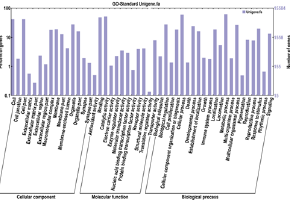
Figure 3. GO categories of the unigenes. Note: The unigenes are annotated in three main categories: biological process, cellular component and molecular function. The right y-axis indicates the number of genes in a category. The left y-axis indicates the percentage of a specific category of genes in that main category.